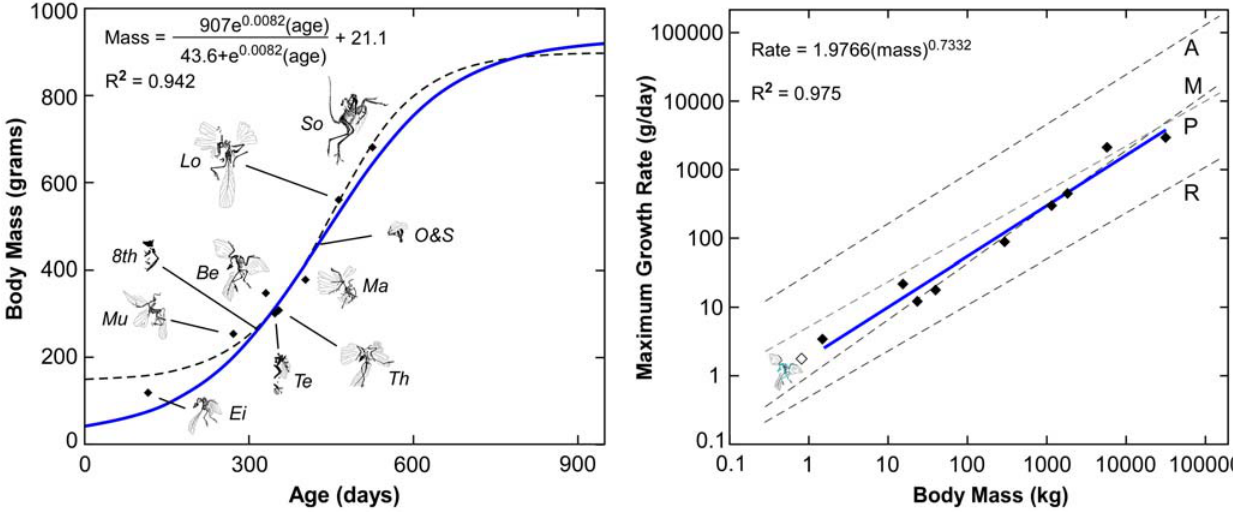
Figure 9. Growth depictions for Archaeopteryx . (Left) The size and estimated age for all ten specimens are depicted. The growth curves are based upon age and size estimates (diamonds) for the eight specimens where femoral length is known. The dashed line represents the best fit for the unconstrained statistical analysis with hatchling and adult size undefined. The solid line represents the best fit when hatchling and adult size are constrained. (Right) The maximal growth rates from these analyses (1.87–2.2 g/day; hollow diamond) fit expectations (1.83–1.87 g/day; [31]) for same-sized non-avialan dinosaurs (solid line) – animals that grew like slow growing endotherms, here compared to marsupials (M). The Archaeopteryx estimates are three times lower than typical rates for extant precocial land birds (5.7 g/day; P], 15 times lower than alticial land birds (28.6 g/day; A), and four times higher than typical rates for extant reptiles (0.46 g/day; R) [32]. Specimens designations: Ei = Eichsta¨at, Mu = Munich, 8 th = 8 th Exemplar, Te = Teyler, Th = Thermopolis, Be = Berlin, Ma = Maxberg, O&S = Exemplar der Familien Ottmann & Steil, Lo = London, So = Solnhofen.